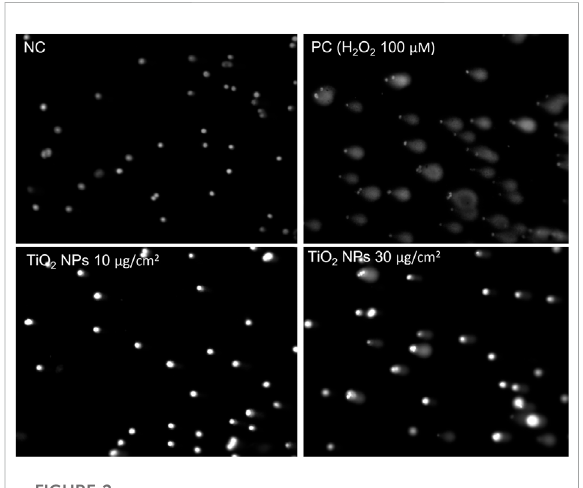
FIGURE 2 Example ofanalyzed sampleswith and withoutDNAdamage. The nucleoids from the unexposed A549 cells (NC) were not affected with the electrophoresis and no increase in the tail was observed.Whilethenucleoidsobtainedfromcellsexposedto thePC(100 μ MH 2 O 2 )andtoTiO 2 NMsat10and30 μ g/cm 2 for3 h show an increase in DNA migrated outside the nucleoids head forming a tail. The image analysis was performed after staining of the samples with SyberGold. For the image analysis Comet IV (Perceptive instruments) was used at ×100 magni fi